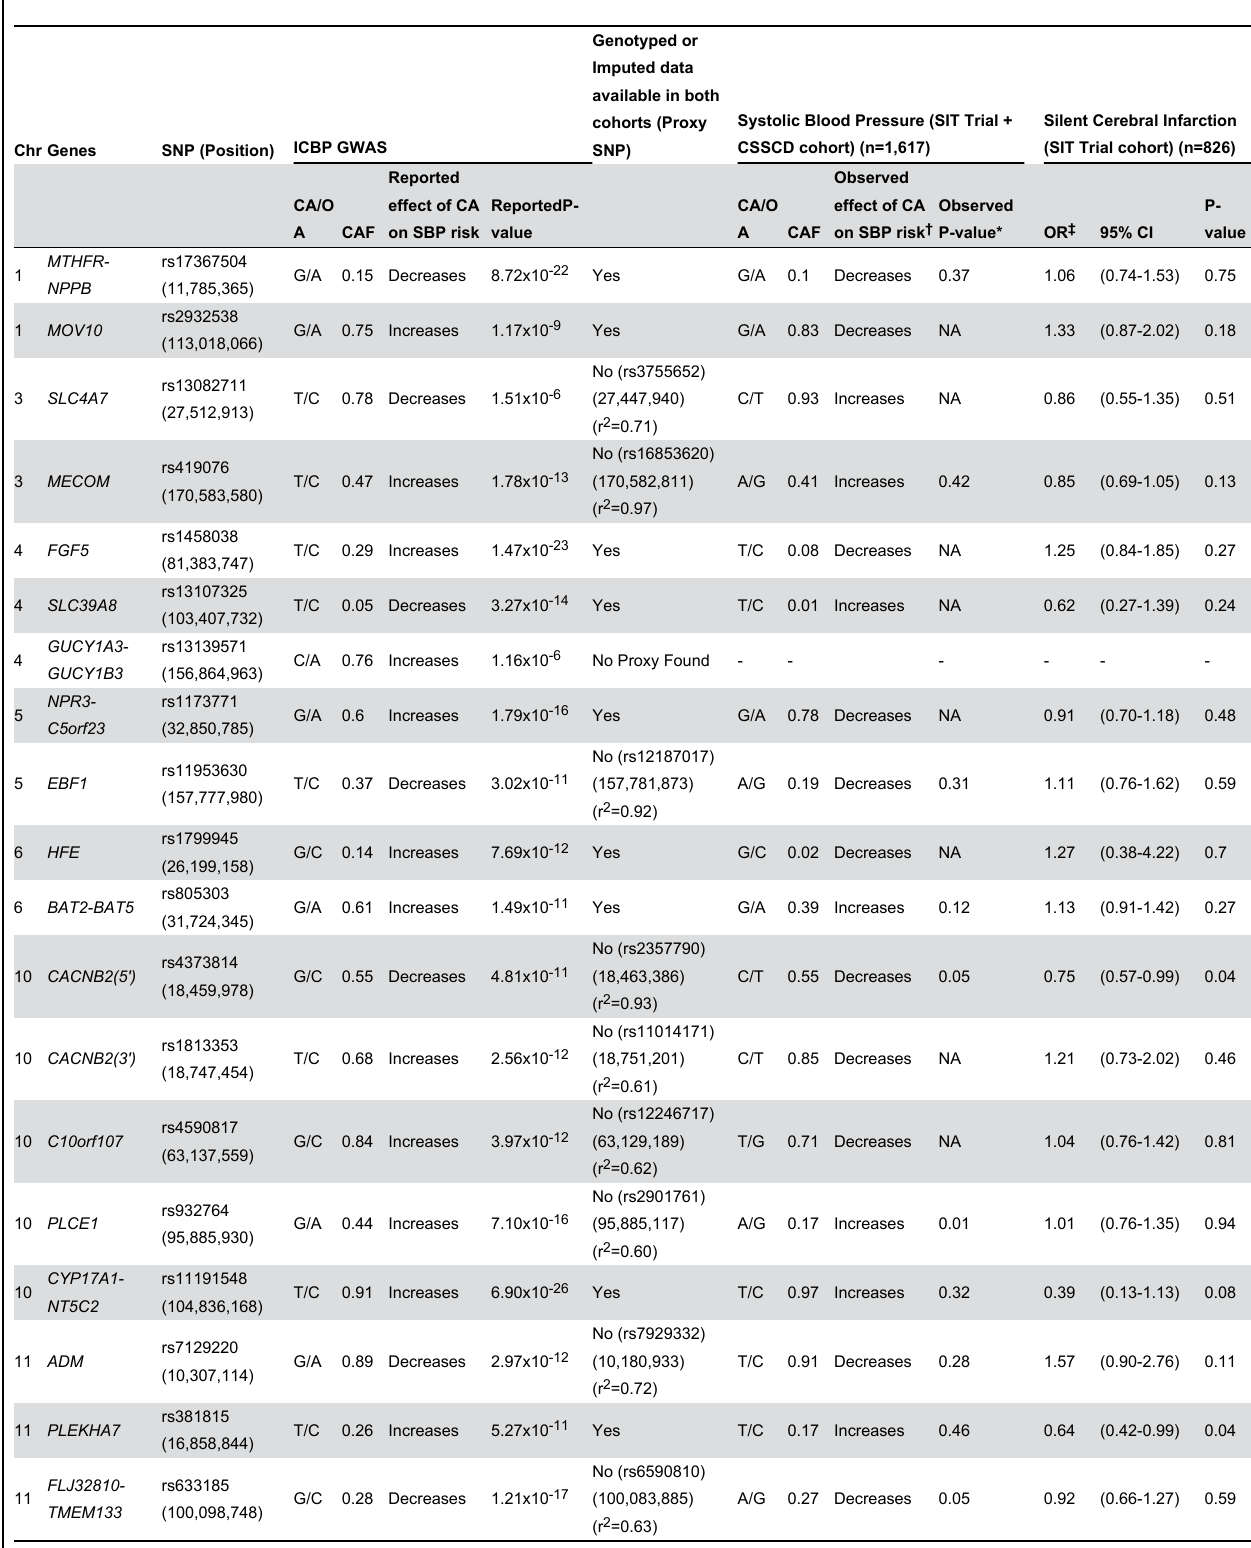
Table 4. Association of previously reported SBP-associated SNPs with SBP and SCI.